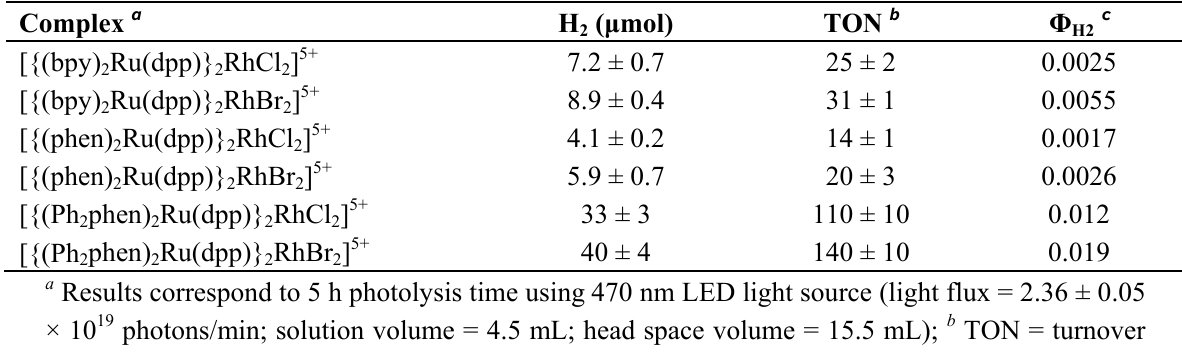
Table 4. Photocatalytic H Supramolecular